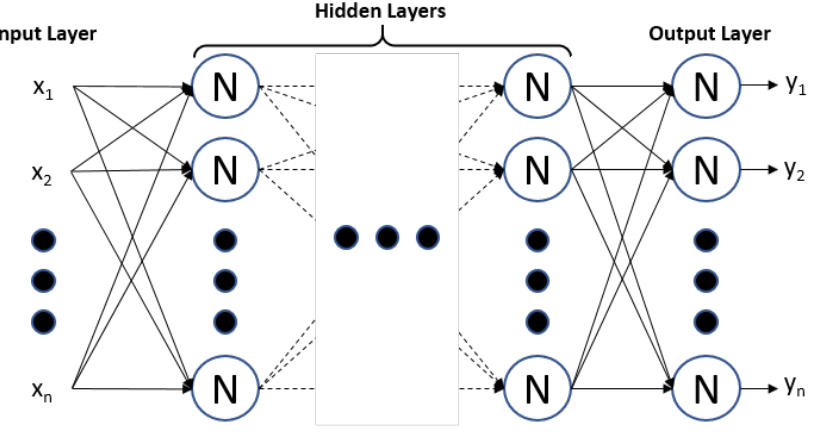
Figure 4. General structure of a feed-forward neural